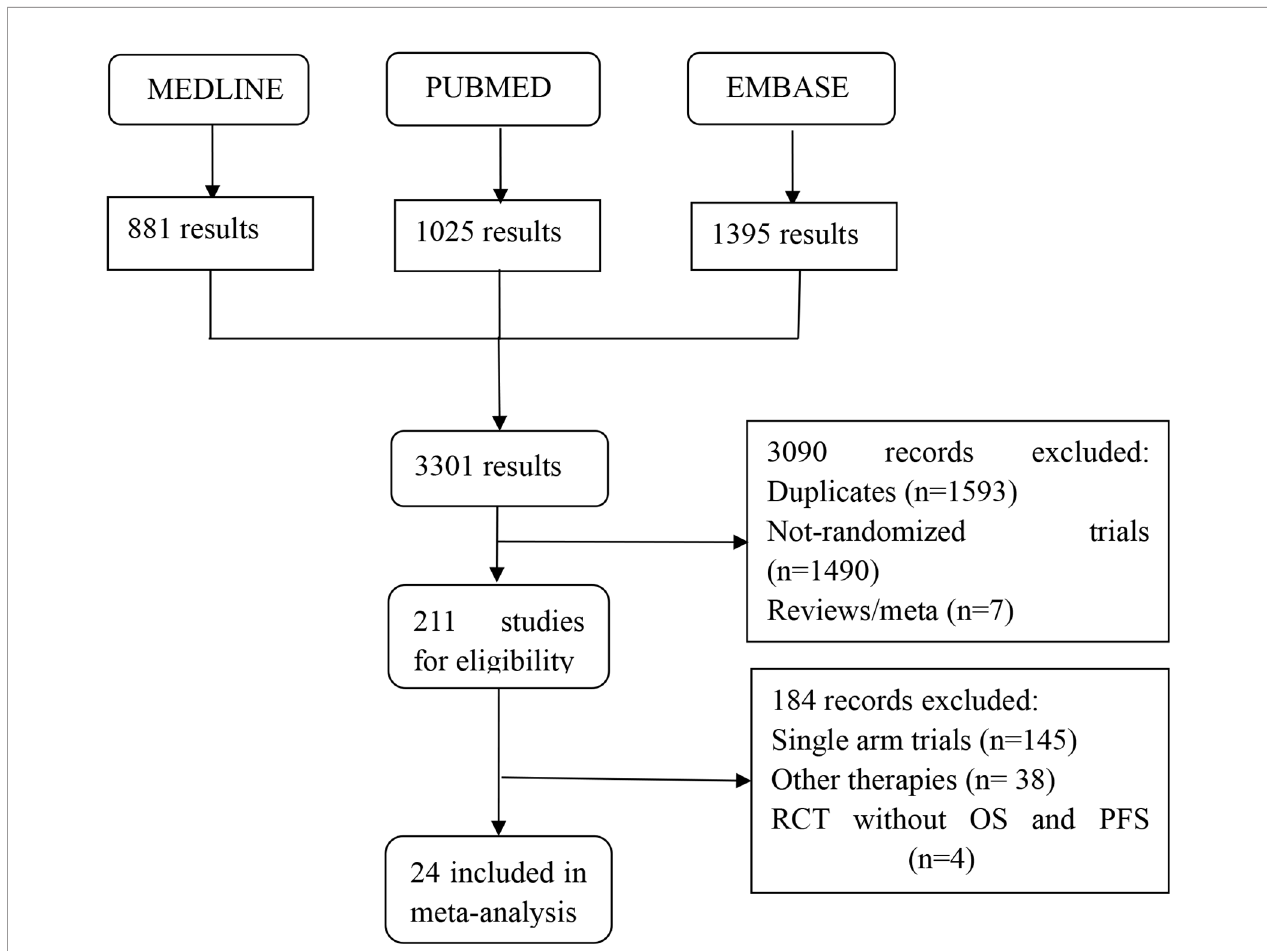
FIGURE 1 | Flow diagram showing inclusion and exclusion of studies according to the PRISMA